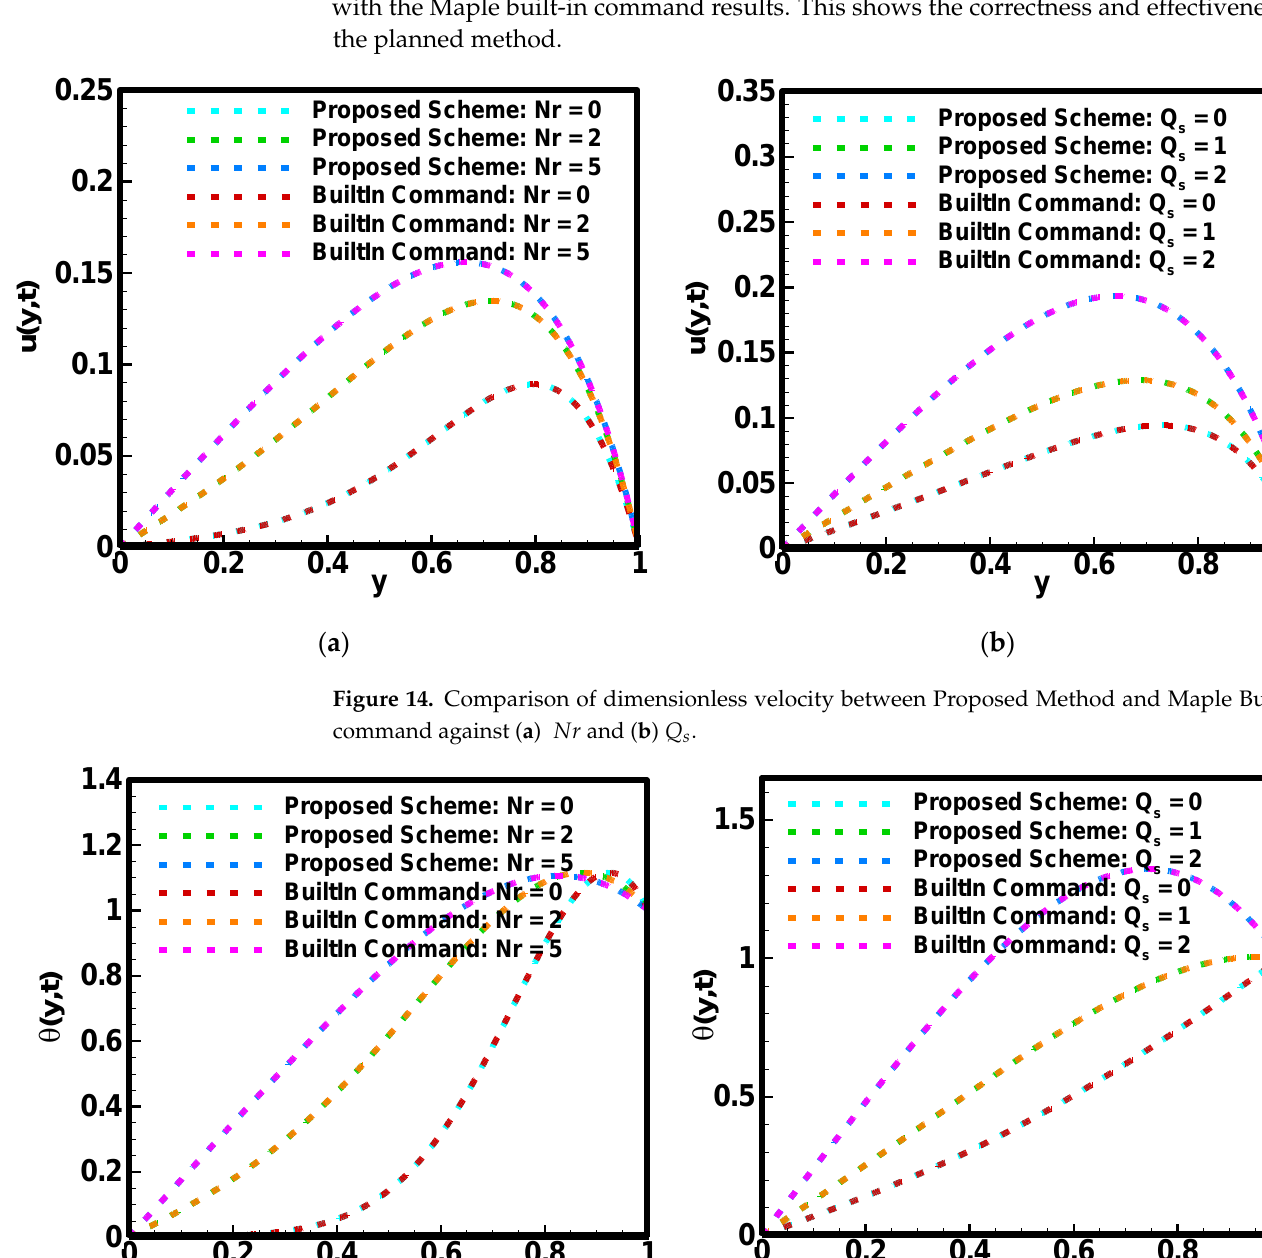
Figure 13. Influence of thermal radiation parameter 𝑁𝑟 on 𝜃(𝑦, 𝑡), when 𝜖 = 0.5, 𝐻𝑎 = 5, 𝑃𝑟 = 21, 𝑄 = 5, 𝜙 = 0.1. 𝑠